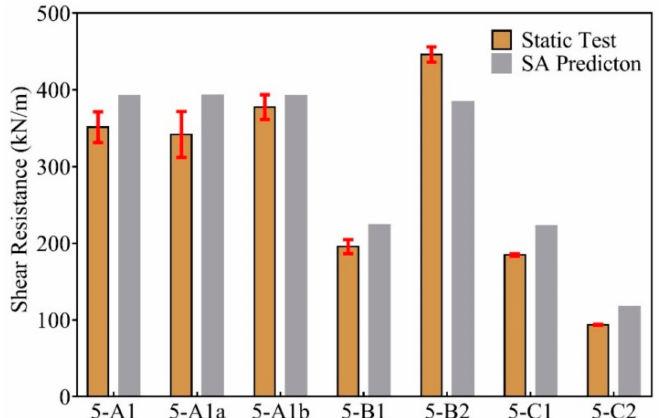
Figure 5. Comparison between measured and calculated shear resistance values.